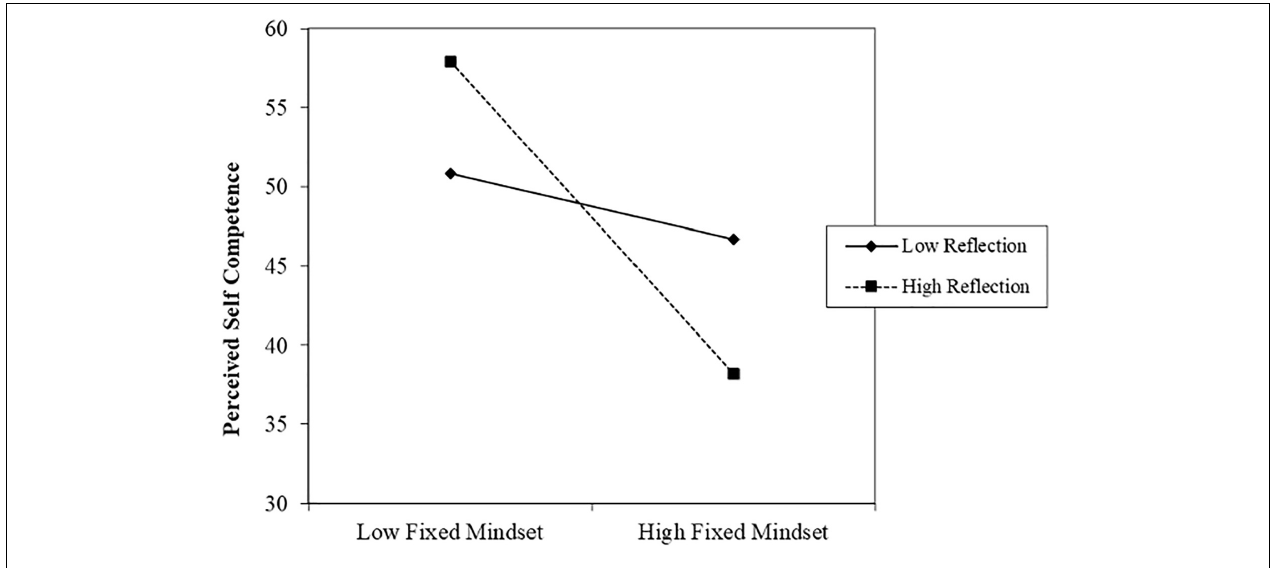
FIGURE 5 | Self-reflection on fixed mindsets and perceived